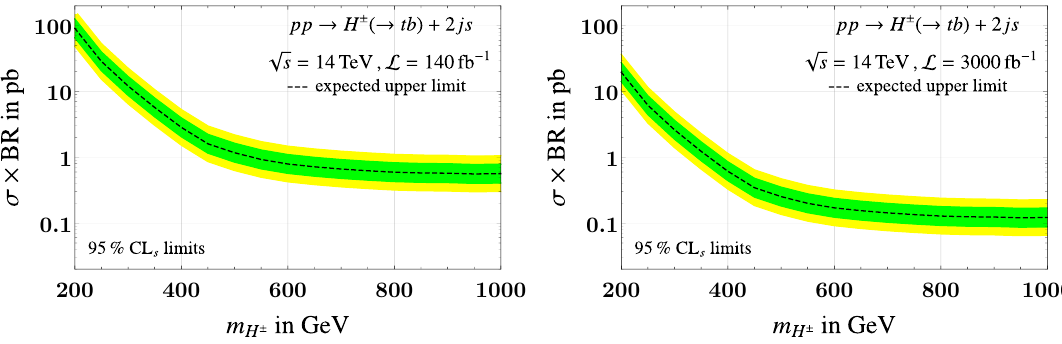
Figure 9 . Expected upper limits at 95% CL s on the production cross section times branching ratio σ ( gq → bH ± ) × BR( H ± → tb ) as a function of the charged Higgs mass. Shown in green (yellow) are the projected limits corresponding to background fluctuations of 68%